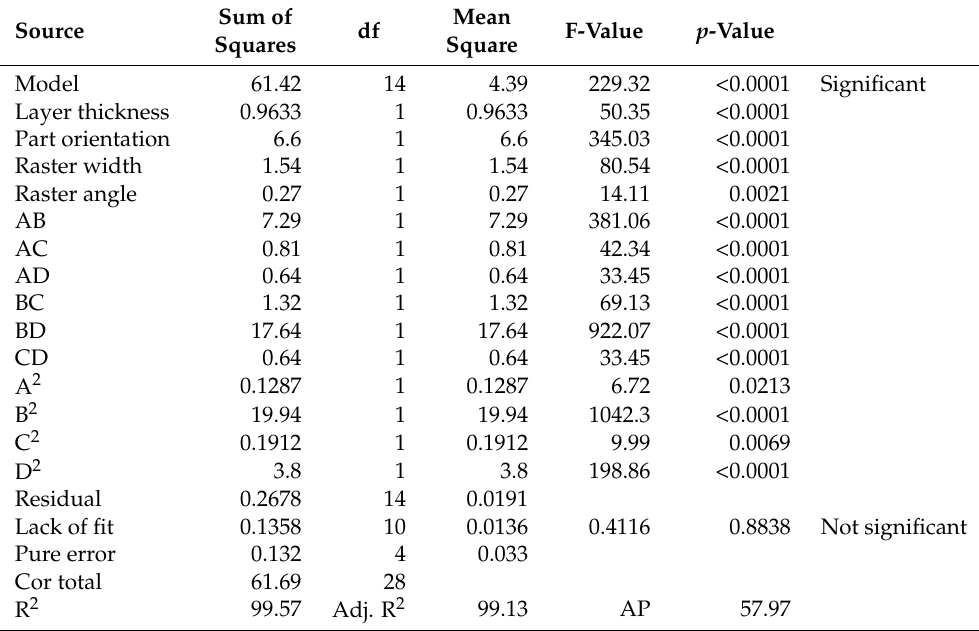
Table 3. Statistical analysis for Ra .